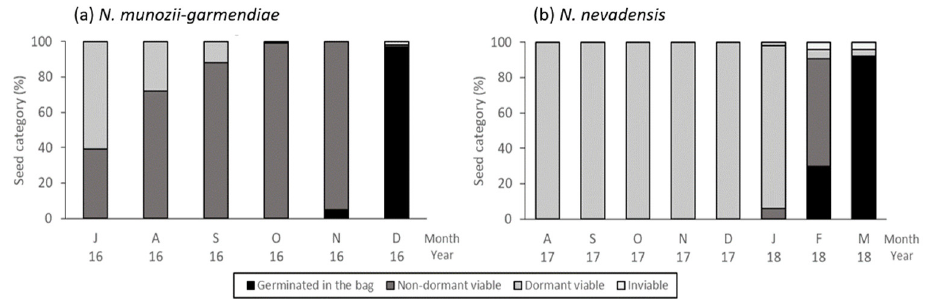
Figure 3. Changes in the percentages of dormant, non-dormant, non-viable, and germinated seeds: ( a ) N. munozii-garmendiae seeds buried during June 2016 and exhumed each month for 6 months; and ( b ) N. nevadensis seeds buried during July 2017 and exhumed each month for 8 months.